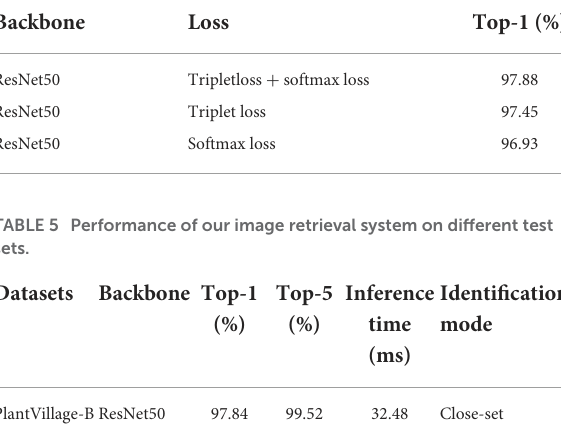
TABLE 4 Comparisons of different loss functions on validation sets.